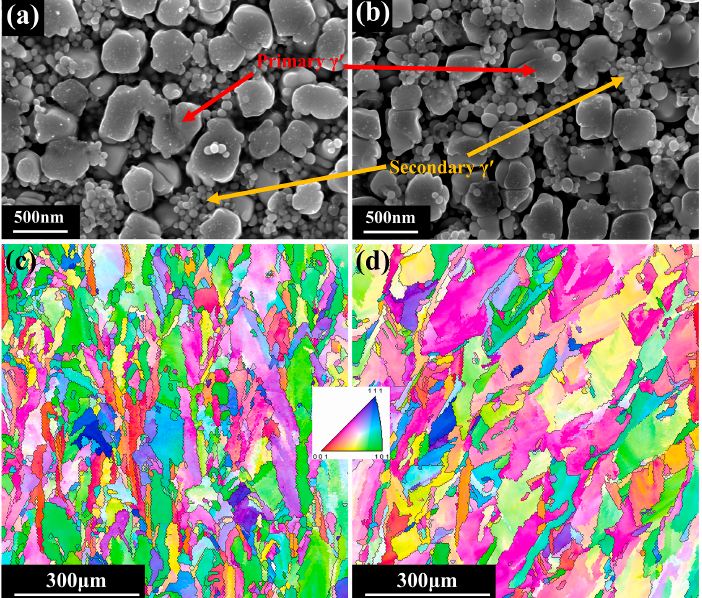
Figure 16. SEM images showing the microstructures ( a ) IN738LC alloy and ( b ) Y 2 O 3 /IN738LC composit, EBSD mapping showing the grain structure of the ( c ) IN738LC alloy and ( d ) Y 2 O 3 /IN738LC composit [57].